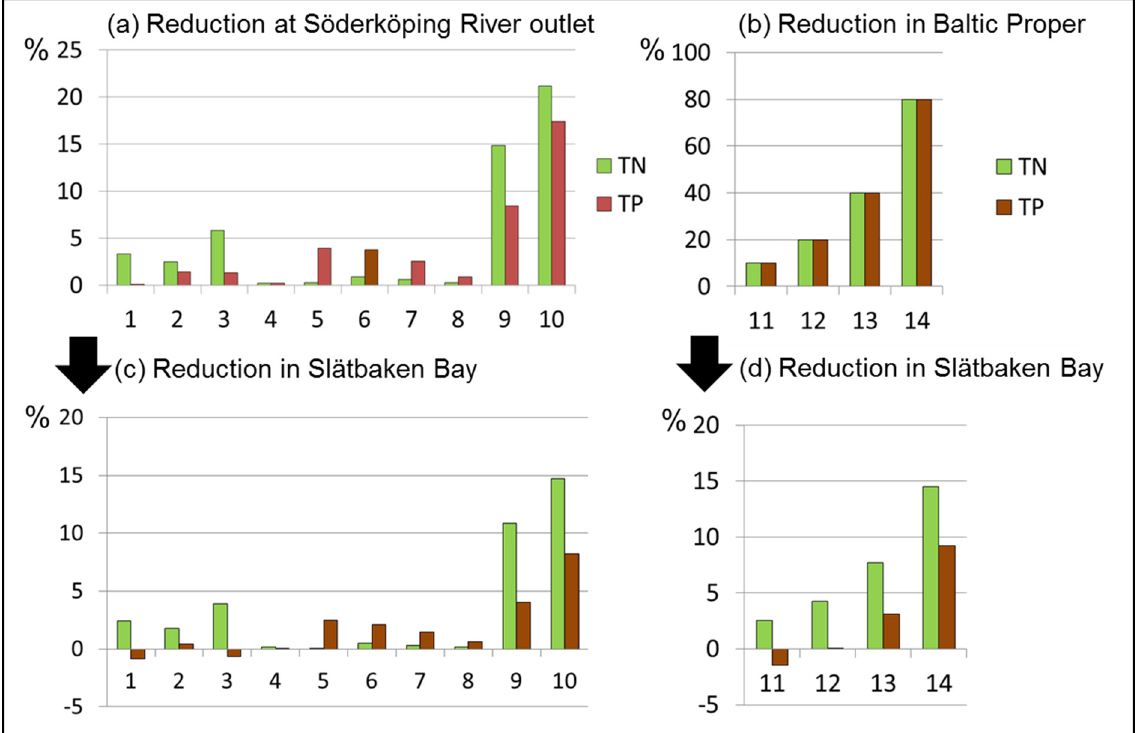
Figure 8. Simulated effect of various remedial measures in total nutrient load from land-based sources ( a ) and reduction in the Baltic Proper ( b ) and their corresponding effect on concentrations in the Slätbaken Bay ( c) and ( d ). Bars correspond to Scenarios No. 1–14 in Table